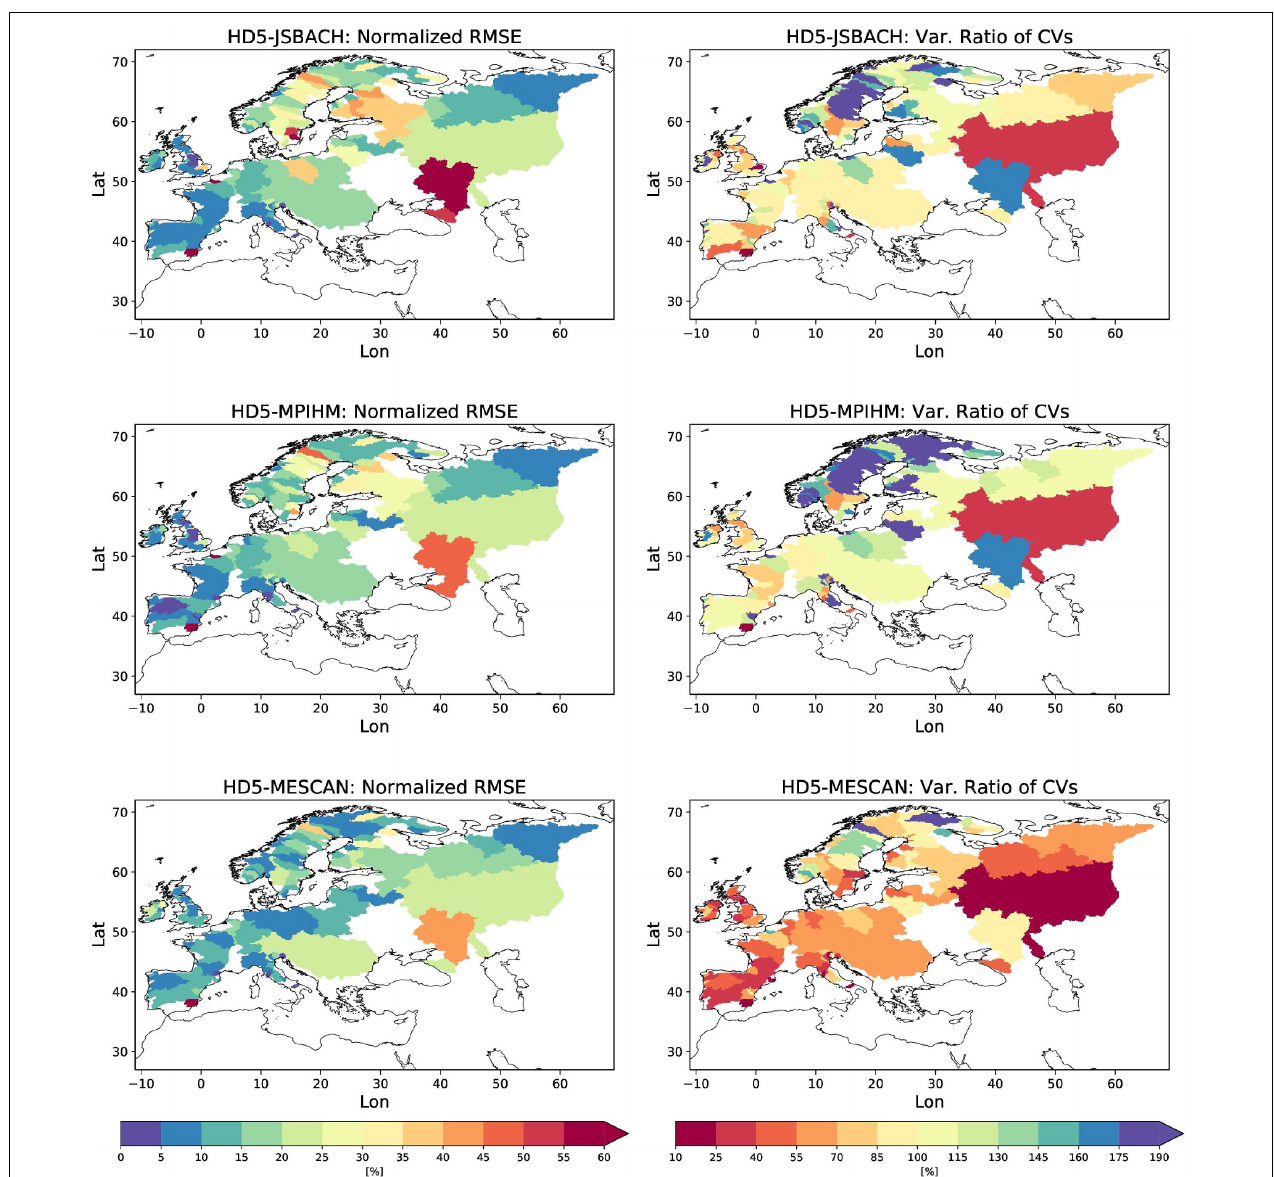
FIGURE 9 | Normalized RSME (left column) and variability ratio of the coefficients of variation (right column) for HD5-JSBACH (1st row), HD5-MPIHM (2nd row), and HD5-MESCAN (3rd row).